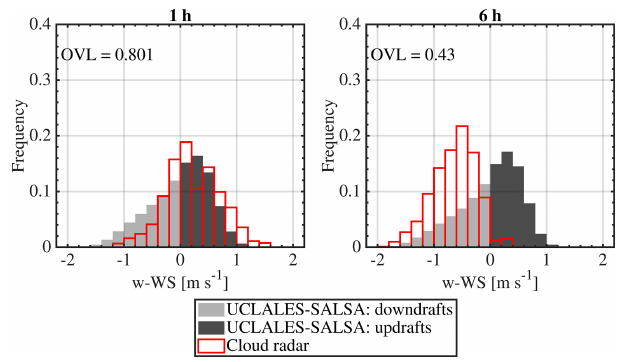
Figure 11. Comparison of model-based distributions of vertical wind at in-cloud conditions during case 2, 31 October 2020, to those retrieved from cloud radar observations. Each panel shows the over- lapping index value (OVL) as an indicator of agreement between